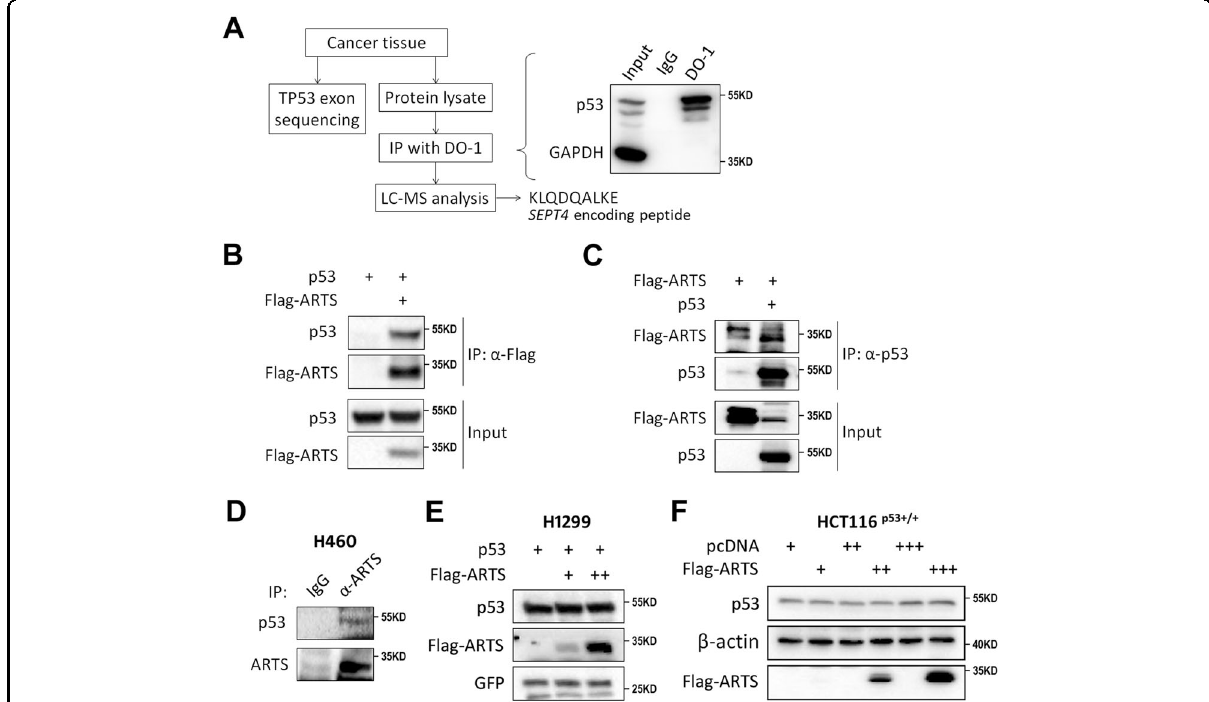
Fig. 4 ARTS interacts with p53. A A schematic of screening for p53-interacting proteins in the cancer tissue harboring mutant p53-S241F. B , C The exogenous interactions between ARTS and p53. H1299 cells were transfected with plasmids as indicated followed by co-IP assays using the anti- fl ag ( B ) or anti-p53 ( C ) antibody. The bound complexes were assessed by IB analysis. D The endogenous interaction between ARTS and p53. The H460 cell lysates were prepared for co-IP-IB assays using the antibodies as indicated. E , F Ectopic ARTS does not affect exogenous ( E ) and endogenous ( F ) p53 stability. H1299 or HCT116 p53 + / + cells were transfected with plasmids as indicated followed by IB